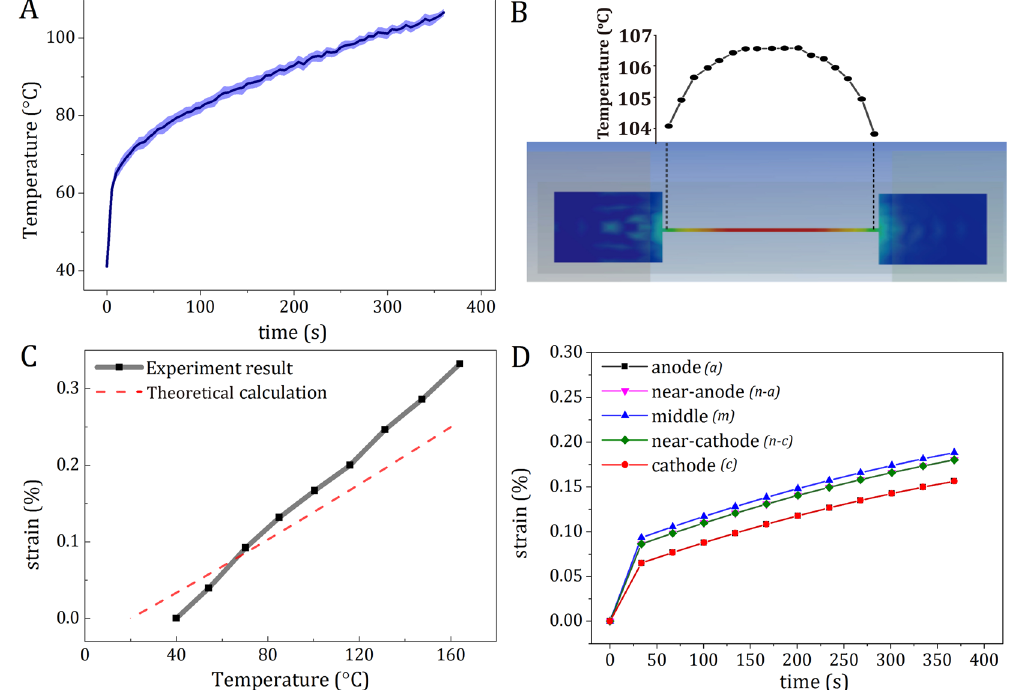
Figure 2. ( A ) The temperature evolution of Cu strips under current stressing at the current density of 4 × 10 5 A/cm 2 . ( B ) The finite-element analysis of temperature distribution along the Cu strip induced by Joule heating at the current density of 4 × 10 5 A/cm 2 . ( C ) The in situ thermal expansion-induced strain (black solid line) of the Cu (111) plane and the derived strain (red dashed line) based on the coefficient of thermal expansion of bulk Cu against temperature. ( D ) The derived Joule heating-induced strain evolutions of the “anode”, “near anode”, “middle”, “near cathode”, and “cathode” of the Cu strip under current stressing at the current density of 4 × 10 5 A/cm 2